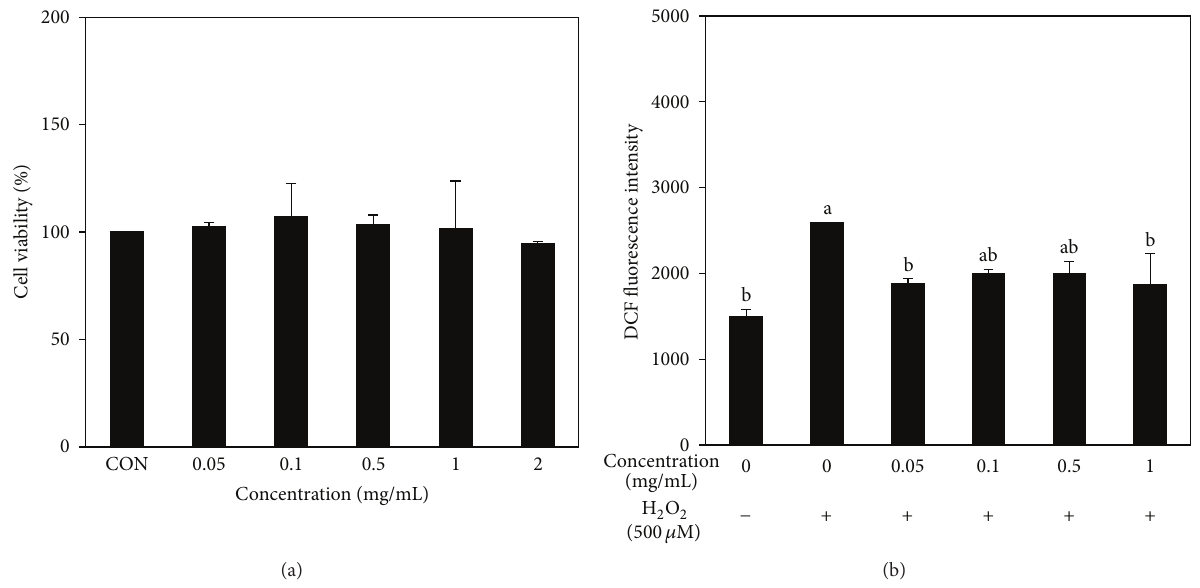
Figure 1: Cytotoxicity (a) and effect on intracellular ROS level induced by hydrogen peroxide (b) of AM in RAW 264.7 cells. After preincubation of the RAW 264.7 cells in 20 𝜇 M DCF-DA, the cells were treated with AM for 120min. DCF fluorescence was measured 490 nm and 𝜆 620 nm. a-b Mean with the different letters is significantly different following addition of 500 𝜇 M H 2 O 2 at 𝜆 excitation excitation ( 𝑃 < 0.05 ) by Duncan’s multiple range